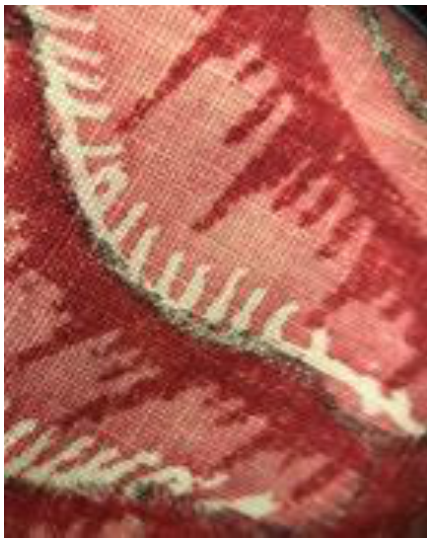
Figure 12. Detail of Figure 11, Courtesy of the Royal Ontario Museum, © ROM. Photograph: Sylvia Houghteling.